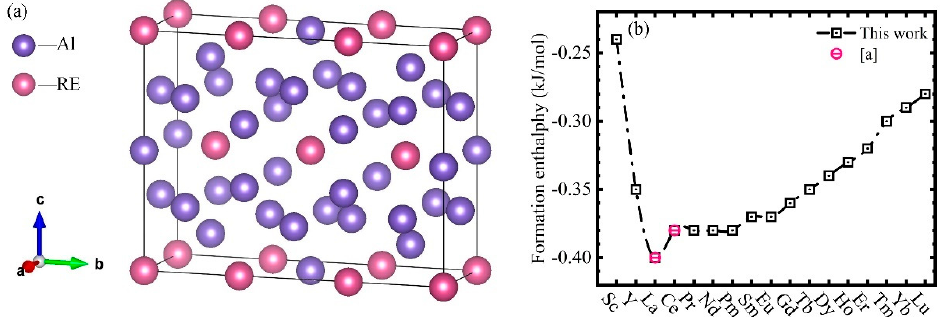
Figure 1. ( a ) The unit cell model of Al 11 RE 3 ; ( b ) the comparison between the calculated and experi- mental values of the formation enthalpy of Al 11 RE 3 . Ref. [a] represents [20].